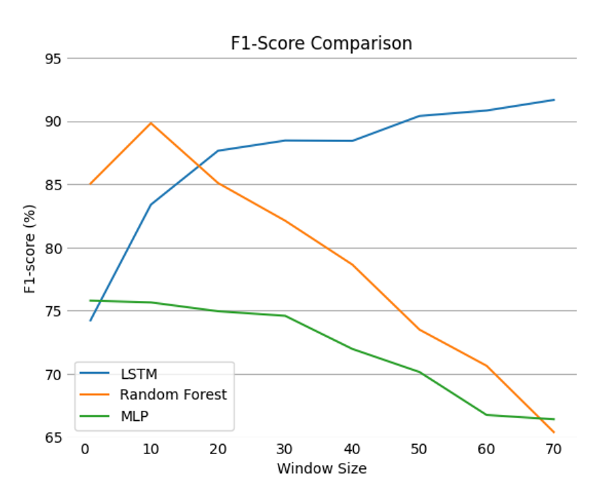
Figure 6. Performance over window size.